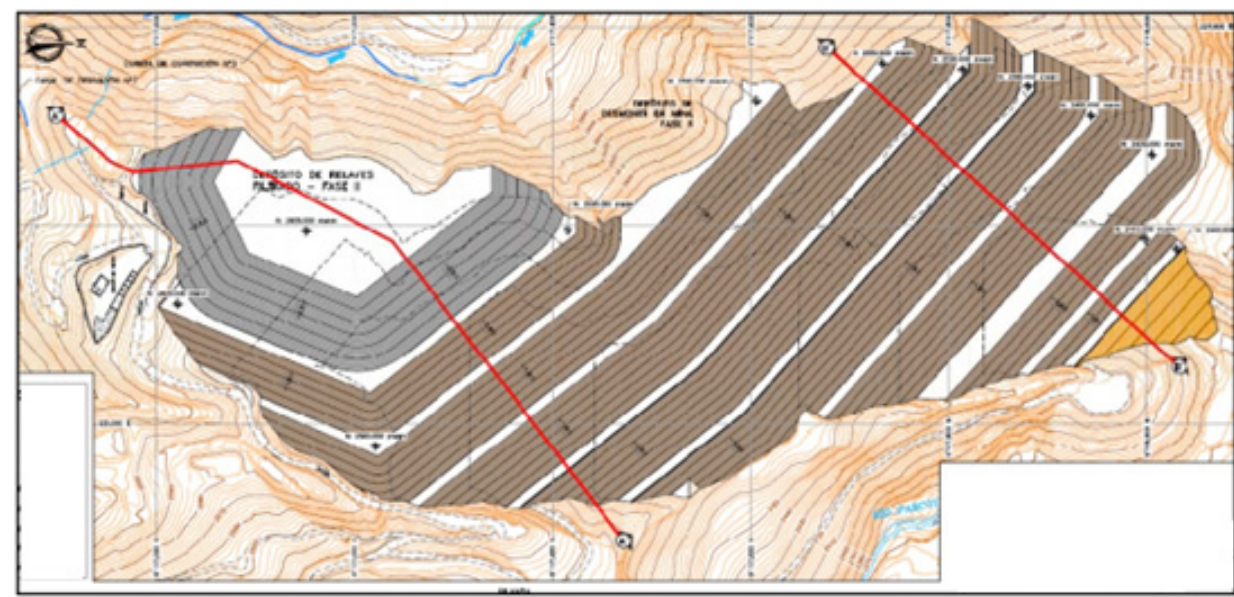
Figure 63. Curaubamba Filtered TSF—Layout [38,39].